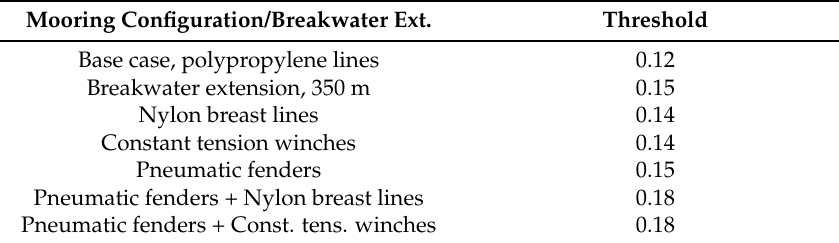
Table 14. Threshold long wave height (m, at Berth 3) for operations at Berth